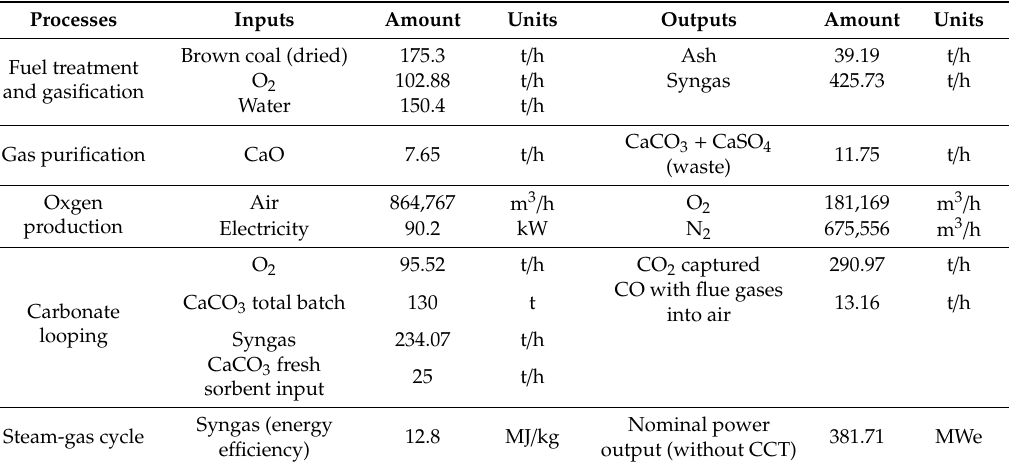
Table 2. Basic inventory data for scenario 1.